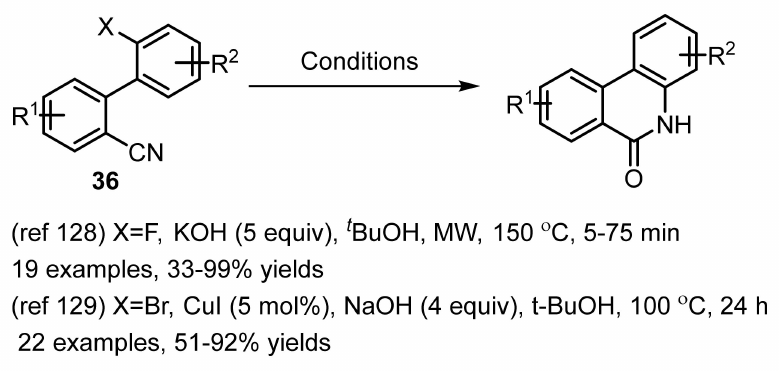
Scheme 19. Transformations of